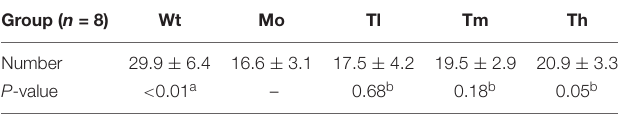
TABLE 2 | Retrieved oocytes after ovulation induction.